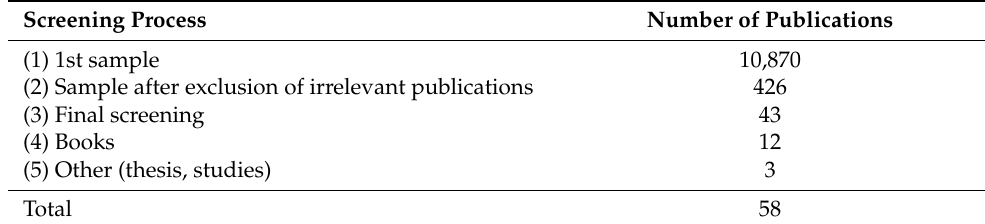
Table 2. Screening of articles on the theme “bio-oil